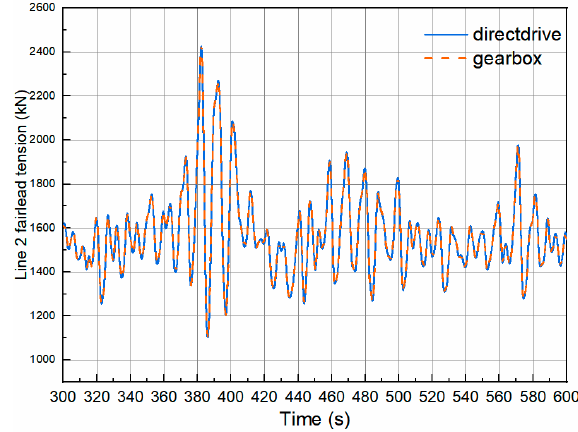
Figure 9. Most loaded line (line 2) fairlead tension (time history).